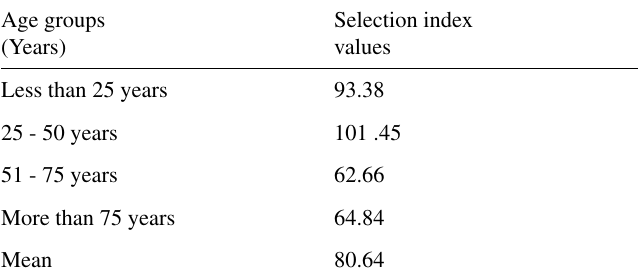
Table 9 - Mean selection index or total index values of four age groups in mangosteen ( Garcinia mangostana